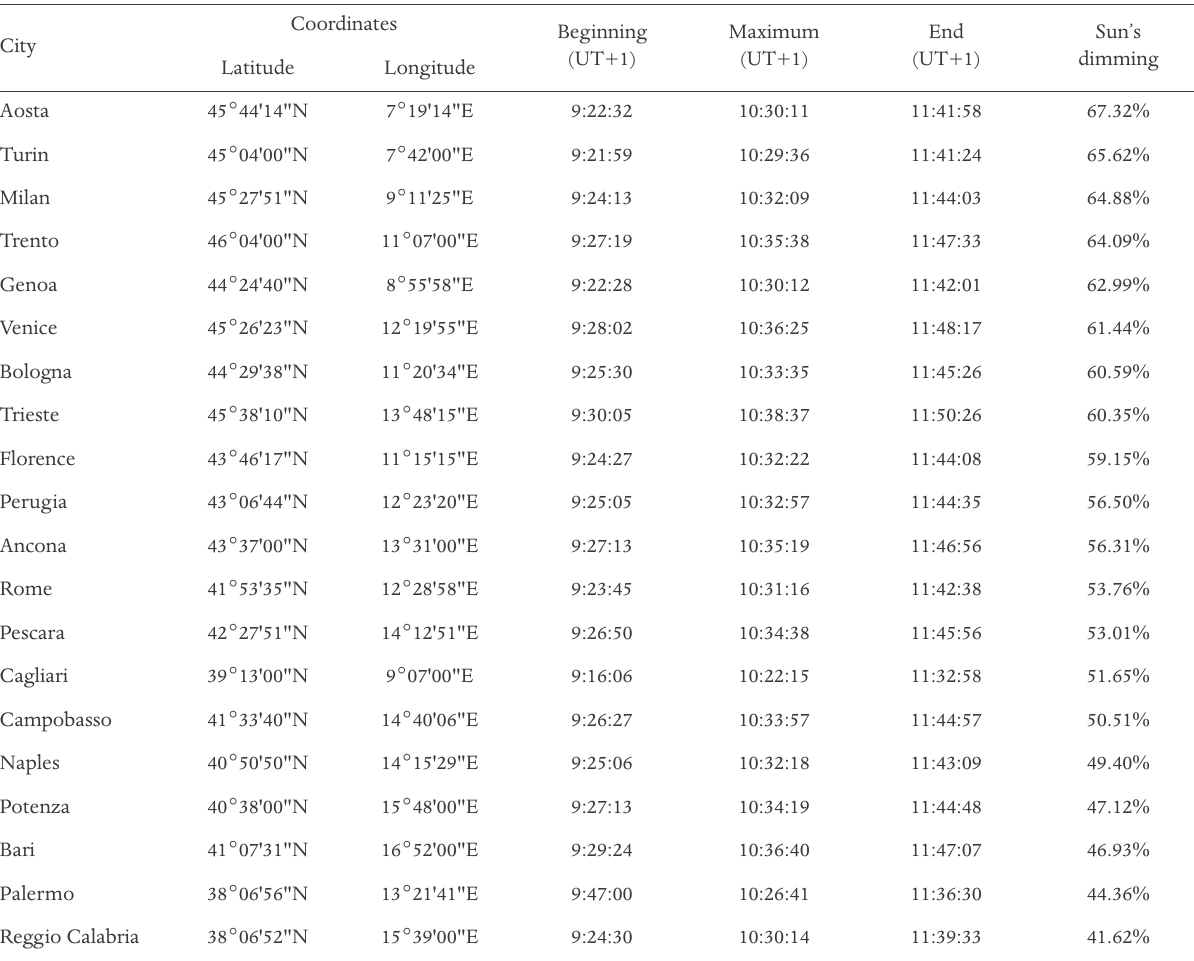
Table 1. Timing and Sun’s dimming of the March 20, 2015, eclipse in major Italian cities. The reported timing is in UT+1 to fit the local Ital- ian time.